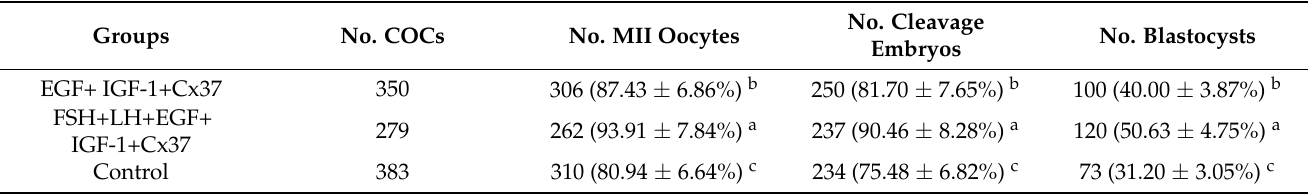
Table 5. Effect of the combination treatment of EGF, IGF-1, and Cx37on the maturation and develop- mental ability of bovine oocytes.